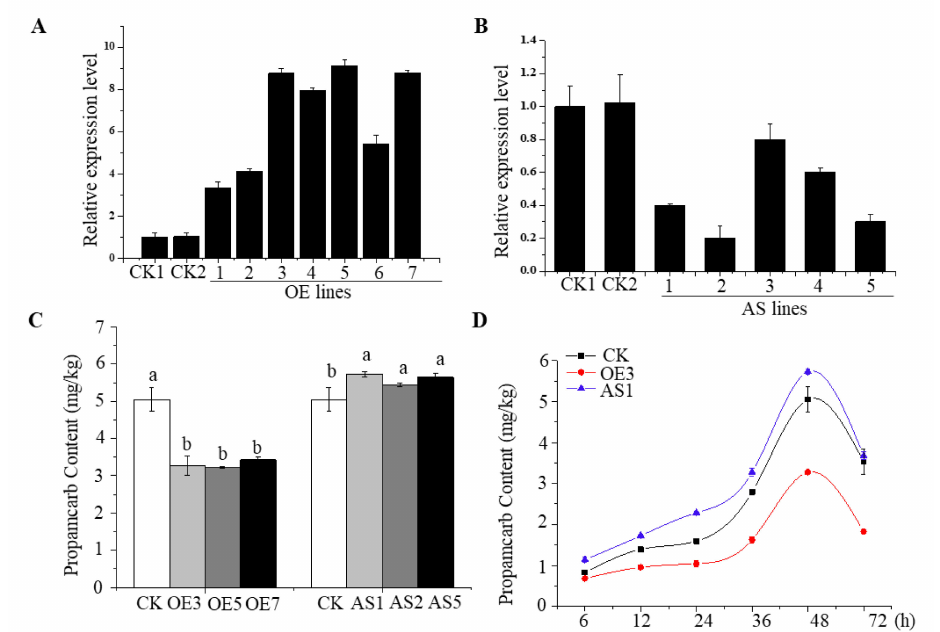
Figure 5. Effects of CsGSH2 overexpression in cucumber. ( A ) CsGSH2 mRNA levels in the control and CsGSH2- overexpressing (OX) plants. ( B ) CsGSH2 mRNA levels in the control and antisense (AS) plants. ( C ) Propamocarb residues in the control, OX, and AS plants at 48 h after propamocarb application. ( D ) Changes in propamocarb residues in control, OX, and AS plants at 6, 12, 24, 36, 48, and 72 h after propamocarb application. Data are the means of three replicates with SEs, and different letters indicate significant differences ( p <